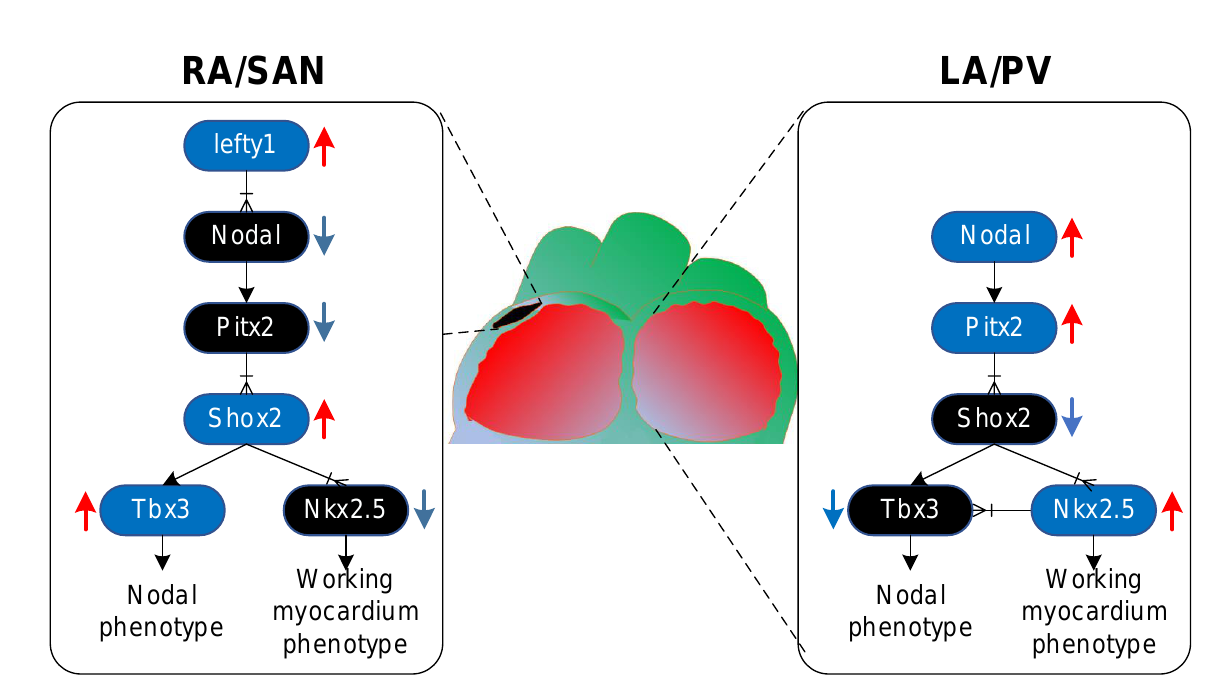
Figure 2. Schematic illustration of PITX2 signaling in atria. Lefty1 represses PITX2 expression in the right atrium (RA), resulting in upregulation of Shox2 that induces sinoatrial nodal (SAN) gene expression through Tbx3. In the left atrium (LA) and pulmonary vein (PV) myocardium, PITX2 is upregulated, leading to downregulation of Shox2 and upregulation of Nkx2.5, which mediates the working myocardium gene expression [31].